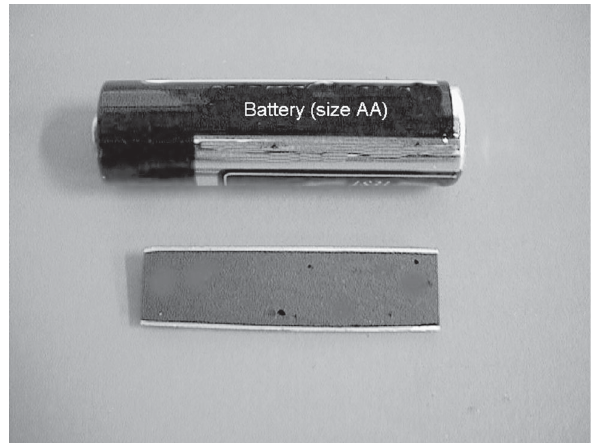
Figure 2. Block of Bi Partial-Melting Route (PMR). The battery (size AA) is included in the figure to illustrate the size of the superconducting block. The magnification of the photo is